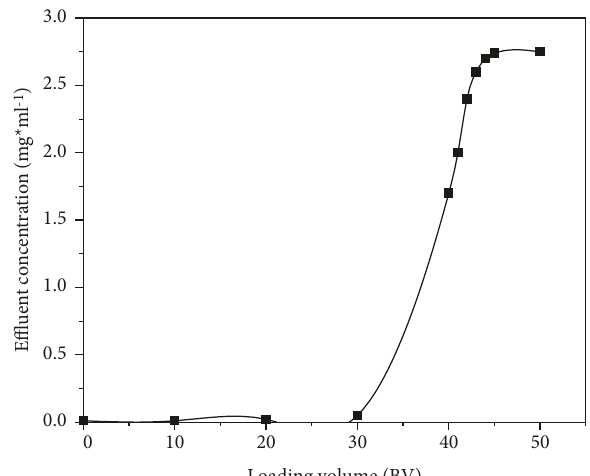
Figure 5: Dynamic breakthrough curve of coumarin adsorption by HPD300 resin.